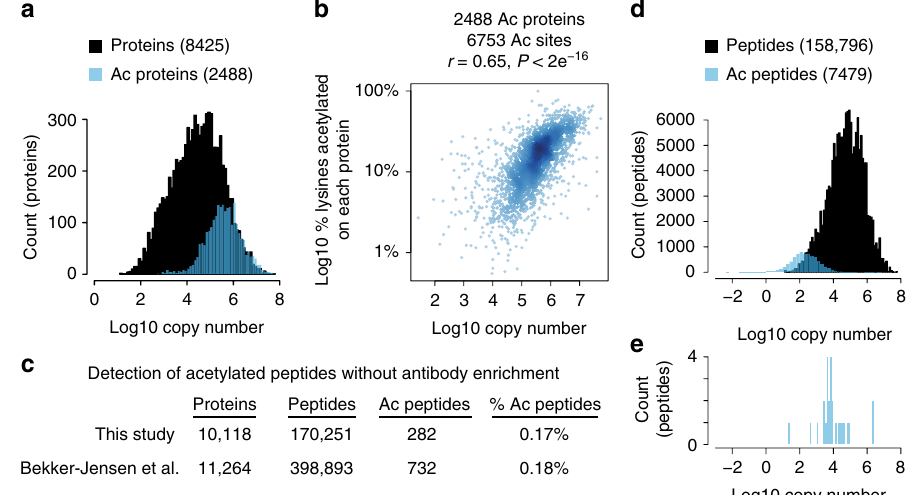
Fig. 2 Stoichiometry limits the detection of acetylated peptides. a Acetylation is biased to detection on abundant proteins. Protein copy number estimates are from 42 . b The fraction of acetylated lysines detected on any given protein is correlated with protein abundance. The scatterplot shows the % lysines acetylated and copy numbers of 2488 acetylated proteins containing 6753 acetylation sites. The Pearson ’ s correlation ( r ), and P -value ( P ) of correlation are shown. c The number of peptides and acetylated peptides (Ac peptides) detected in deep proteome measurements from this study and 13 . d The distribution of peptide copy numbers from a deep proteome measurement and acetylated peptide copy numbers calculated from the peptide stoichiometry and protein copy number. e The distribution of acetylated peptide copy numbers for acetylated peptides that were detected without prior antibody enrichment. Source data are provided as a Source Data fi